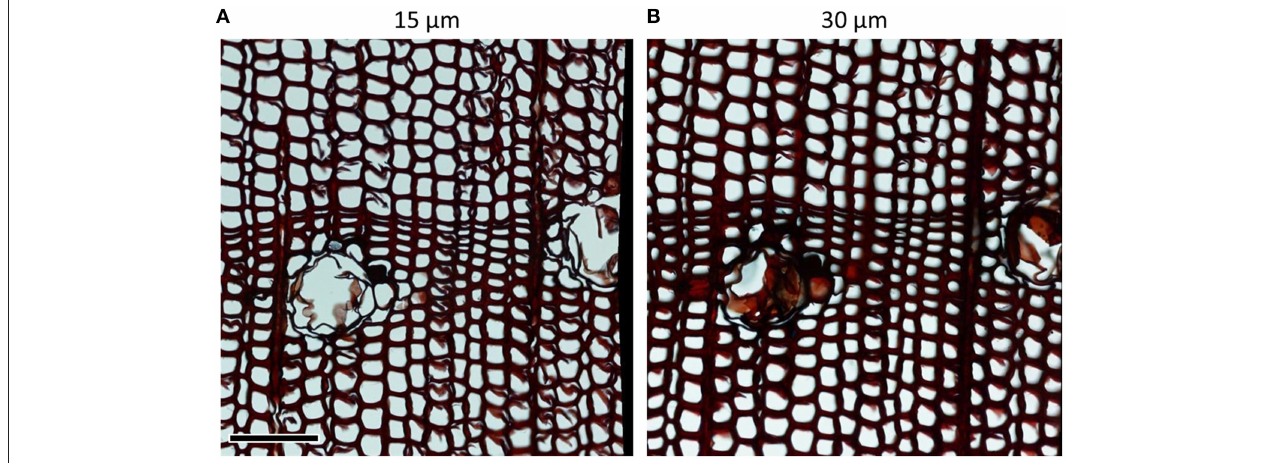
FIGURE 1 | Damage to cell walls due to dull blades in Pinus heldreichii cross-sections of (A) 15 µ m and (B) 30 µ m thickness. In conifer samples, wall fragments rip off particularly easily at bordered pits. Such problems are aggravated in thinner sections as in panel (A) . Scale bar = 100 µ m.